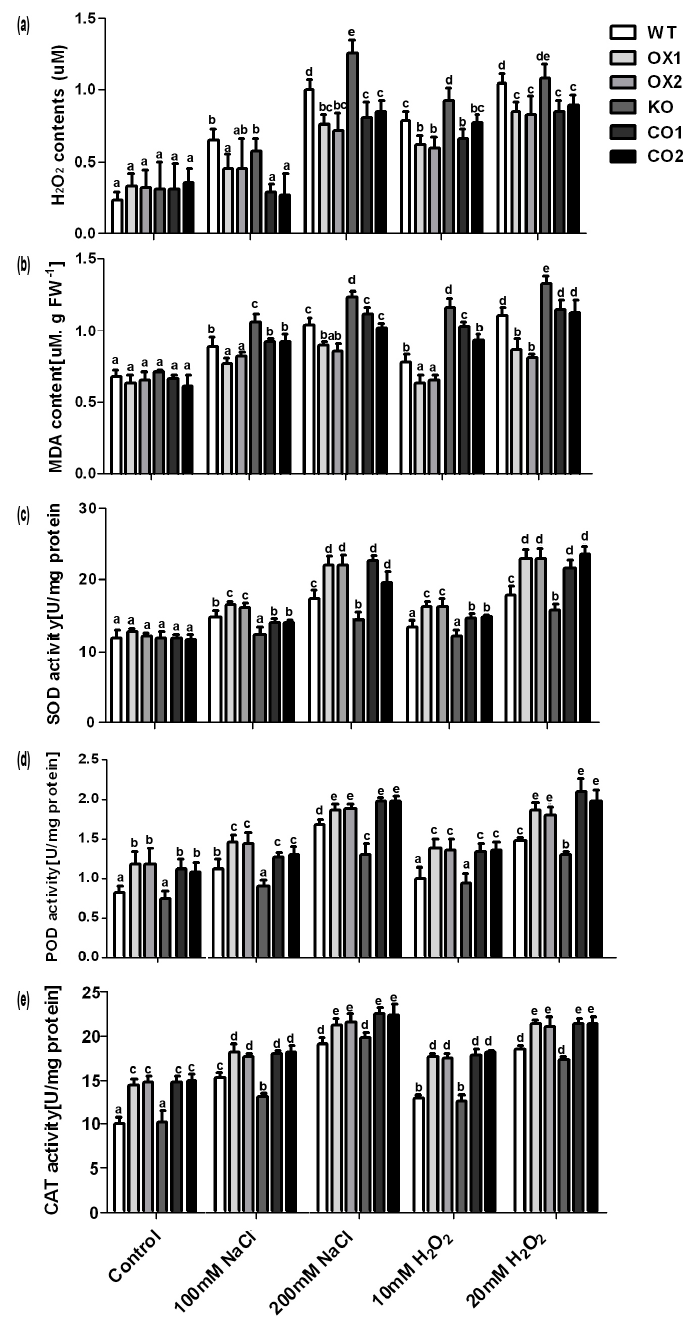
Figure 6. Effects of salt and H 2 O 2 stresses on antioxidant system activity H 2 O 2 content ( a ); malondialdehyde (MDA) content ( b ); and antioxidant enzyme activities ( c – e ) were measured in wild type (WT), transgenic BvM14-SAMS2 wild type (WT), BvM14-SAMS2 -overexpressed in wild type Arabidopsis (OX), atsams3 mutant (KO) and transgenic BvM14-SAMS2 in the mutant seedlings (CO) leaves. Data are the means of three biological replicates (SD) and each replicate contains five seedlings. Different letters indicate significant difference at p < 0.05.